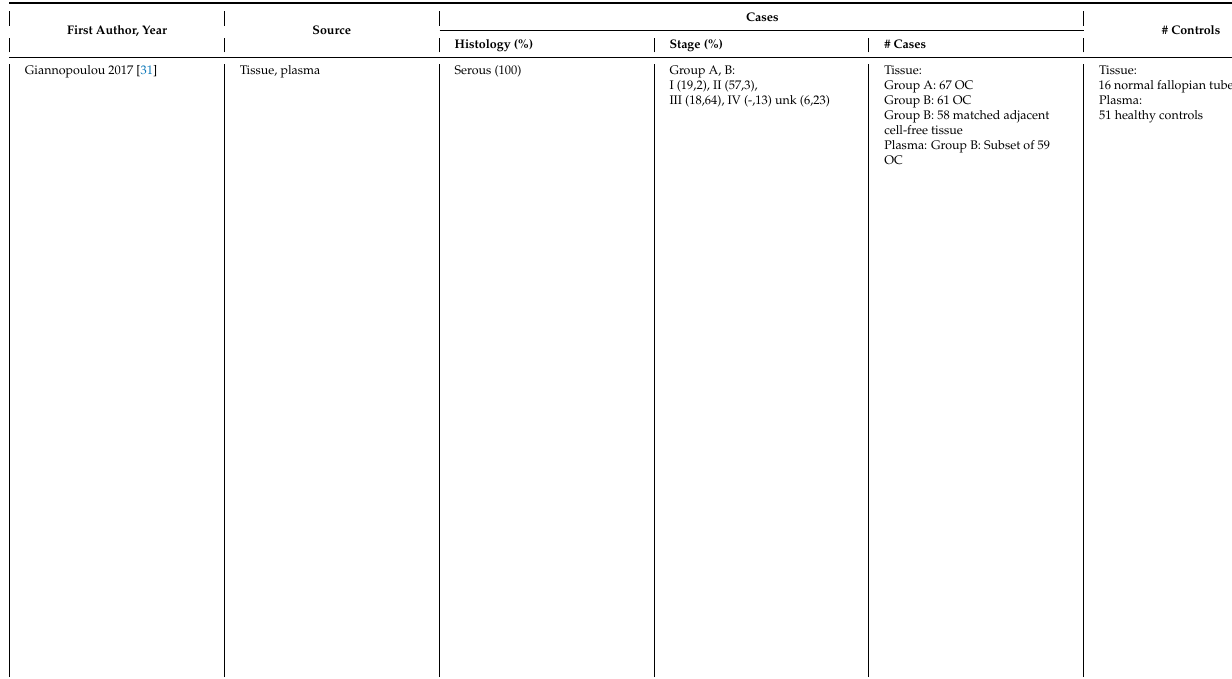
forplasmasamples. ———————–